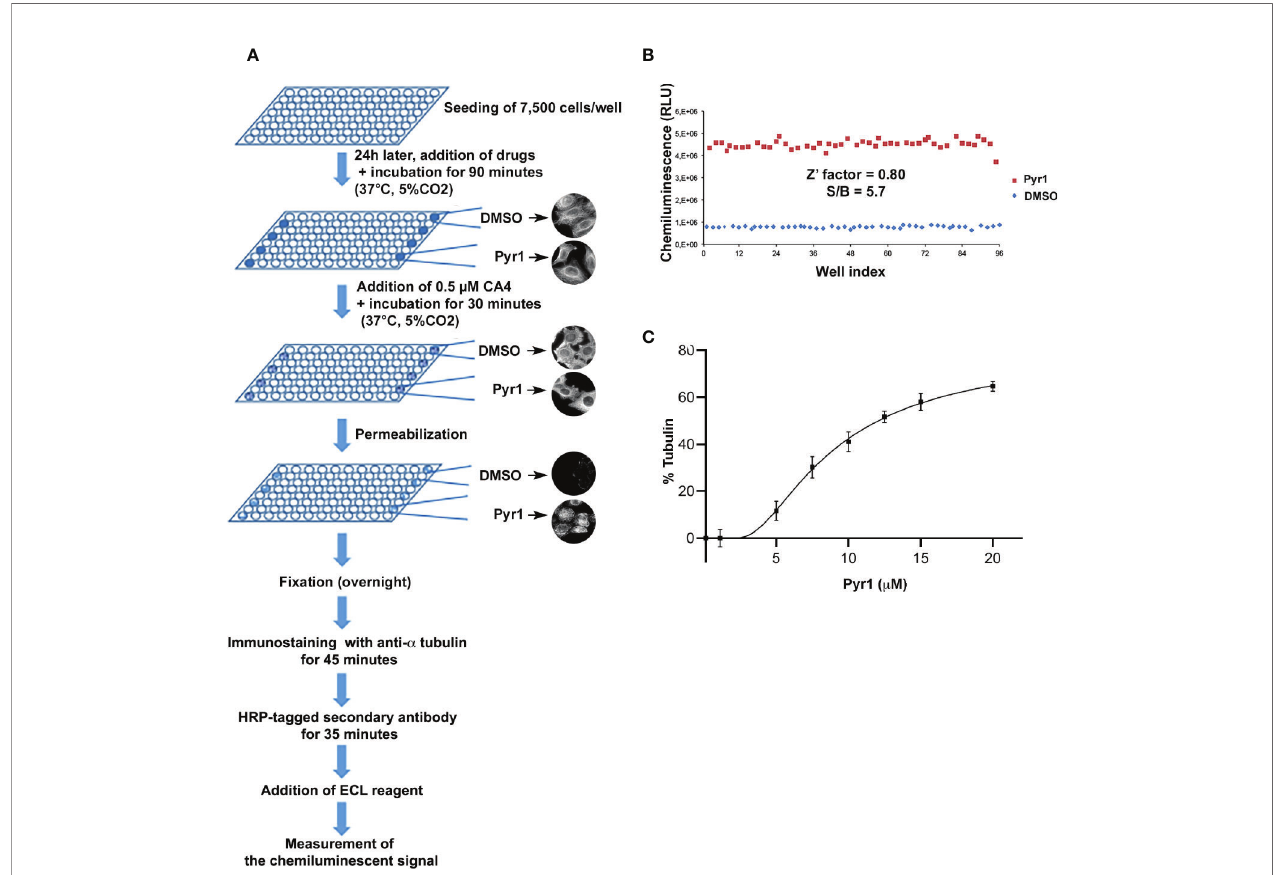
FIGURE 1 | A cell-based assay for detecting microtubule stabilizing agents. (A) Schematic representation of the different steps of the assay. (B) Evaluation of the intra-assay repeatability. HeLa cells were seeded on a microplate. After 24 h, they were treated for 90 min with DMSO (negative control, blue diamonds) or Pyr1 25 µM (positive control, red squares). Then CA4 was added to each well at a fi nal concentration of 0.5 µM for 30 min. Cells were then processed for chemiluminescence, as described in the Materials and Methods section. Each point represents the luminescence intensity (expressed as Relative Luminescence Units) obtained for each well of the 96-well microplate. (C) Evaluation of the assay sensitivity. HeLa cells were seeded on microplates. After 24 h, they were treated for 90 min with DMSO (negative control) or with different concentrations of Pyr1 as indicated. CA4 was added to each well at a fi nal concentration of 0.5 µM for 30 min. Cells were then processed for chemiluminescence, as described in the Materials and Methods section. Results are expressed as % of MTs resistant to CA4 induced depolymerization, with 100% corresponding to cells treated with DMSO without CA4 and 0% corresponding to cells treated with DMSO and CA4; mean +/ − SEM.